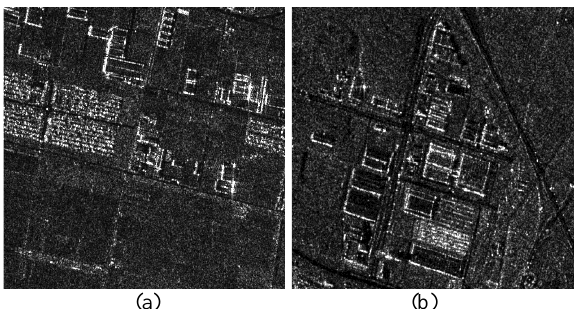
Fig 4. GF-3 SAR Image: (a) Image1, (b) Image2.